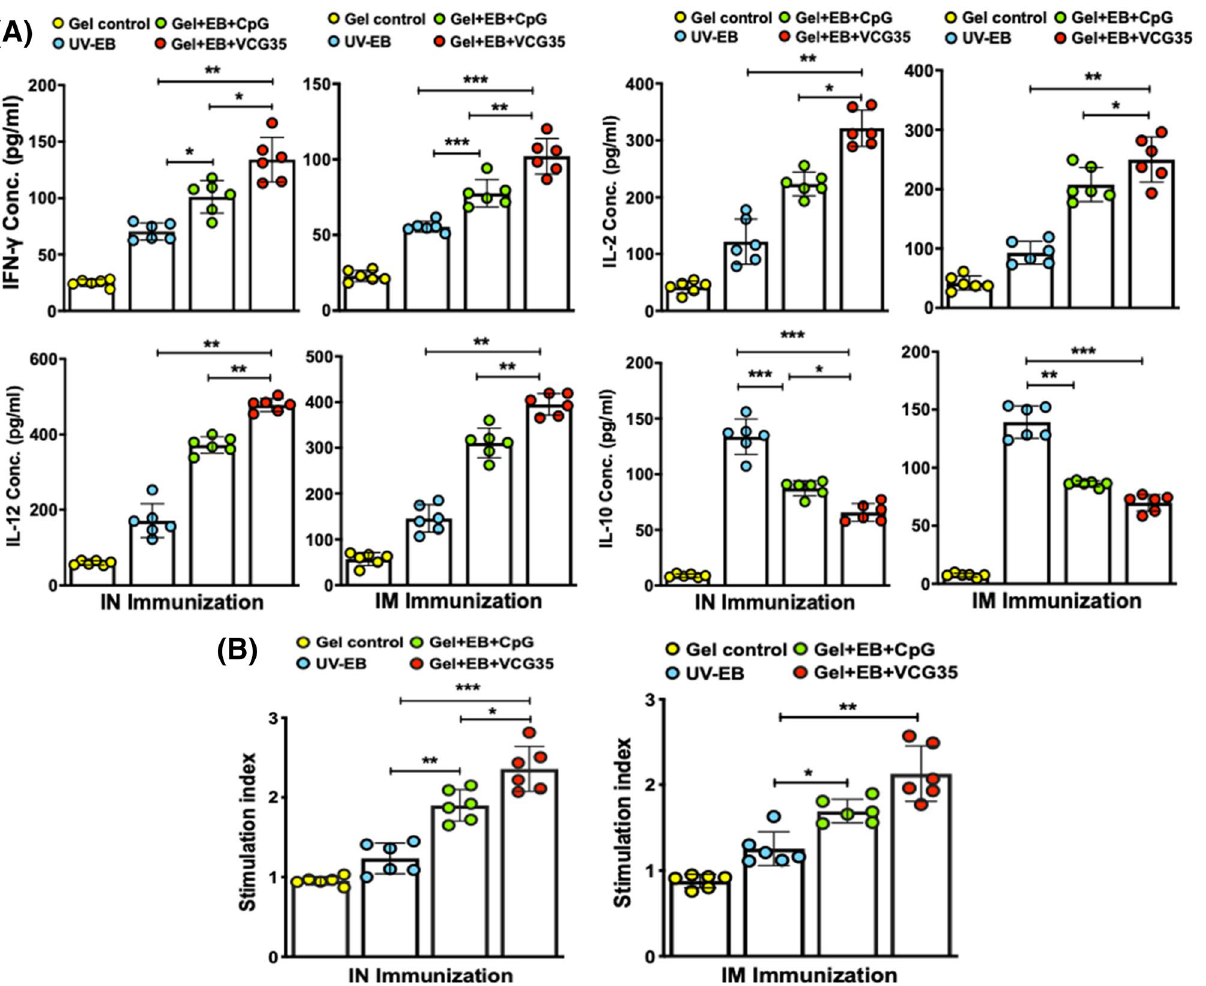
Figure 2. Cytokine levels in lung lavage fluid and Chlamydia psittaci -specific proliferative responses of peripheral blood mononuclear cells (PBMCs). Groups of chickens were immunized and boosted IN or IM as described in the materials and methods section. ( A ) Two weeks after the booster immunization, the amount of IFN-γ, IL-2, IL-12 and IL-10 cytokines contained in lung lavage fluids from chickens immunized IN or IM (6/ group) was measured using single cytokine assay kits. The concentration of the cytokines in each sample was obtained by extrapolation from a standard calibration curve generated simultaneously. Each cytokine ELISA assay was performed twice with similar results. The data shown is one of those two assays and the bars represent the mean cytokine concentrations (± S.D.) in samples from six chickens in each group. ( B ) PBMCs obtained from six chickens/group by Lymphoprep density gradient centrifugation 2 weeks after the booster immunization were restimulated in vitro with 10 6 IFU of UV-irradiated C. psittaci EBs ( C. psittaci antigen) for 24 h at 37 ℃ in 5% CO 2 . Antigen-specific proliferative responses were determined using the 5-Bromo-2’-deoxy-uridine (BrdU) cell proliferation assay kit (Abcam, Beijing, China) as described in the Materials and Methods section. BrdU incorporation was detected by addition of anti-BrdU antibody and the absorbance was read at 450 nm. Results are expressed as the stimulation index (SI), the ratio between absorbance values of stimulated and non- stimulated cells. The bars represent the mean SI values (± S.D.) of samples from six chickens in each group and the data shown is one of two independent lymphoproliferative assays with similar results. Significant differences between groups were evaluated by One-way ANOVA with Tukey’s post multiple comparison test at p * < 0.05, p * < 0.01 and p *** <